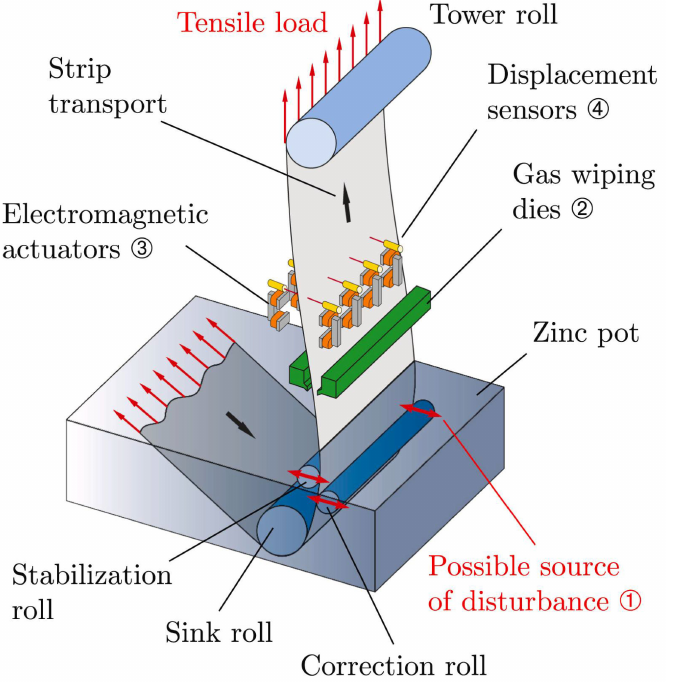
Figure 14. Schematic representation of hot dip galvanising process. Reprinted with permission from [73]. 2020,